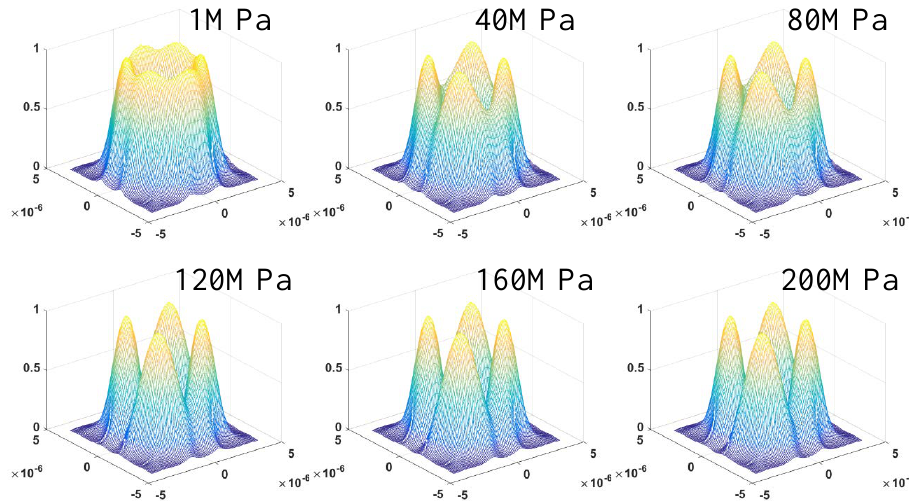
Figure 7 . The normalized intensity distribution for the even mode of HE31 under 1–200 MPa stress in the y direction.